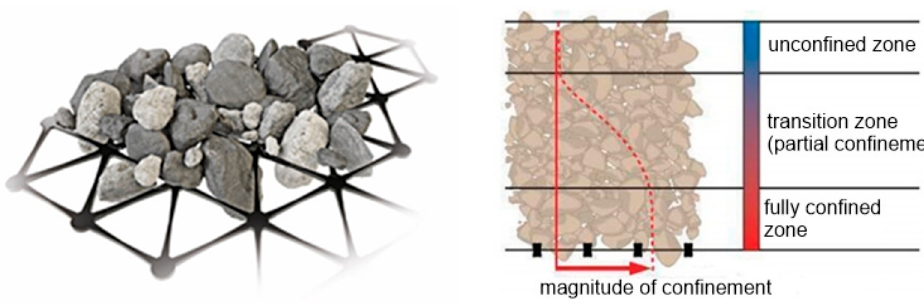
Figure 18. Confinement of particles provided by aggregate interlocking in geogrid apertures ( left ) and its magnitude distribution